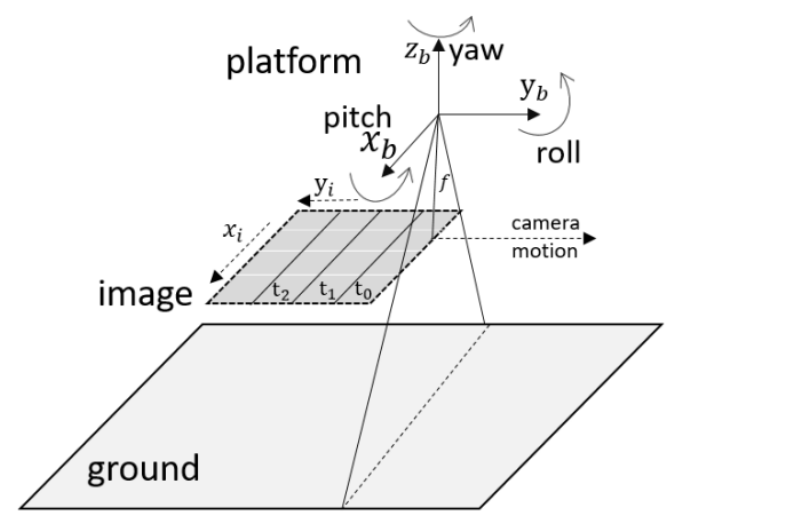
Figure 1. Overview of the pushbroom acquisition principle.